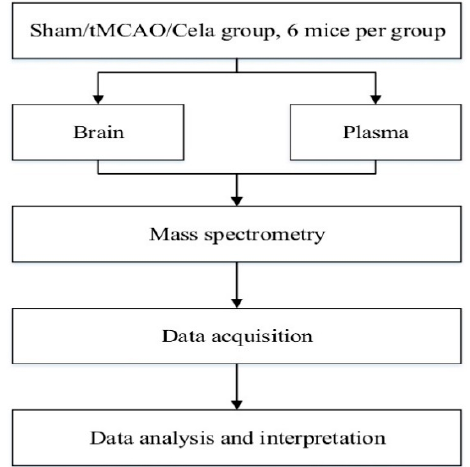
Figure 7. Workflow of the lipidomics.